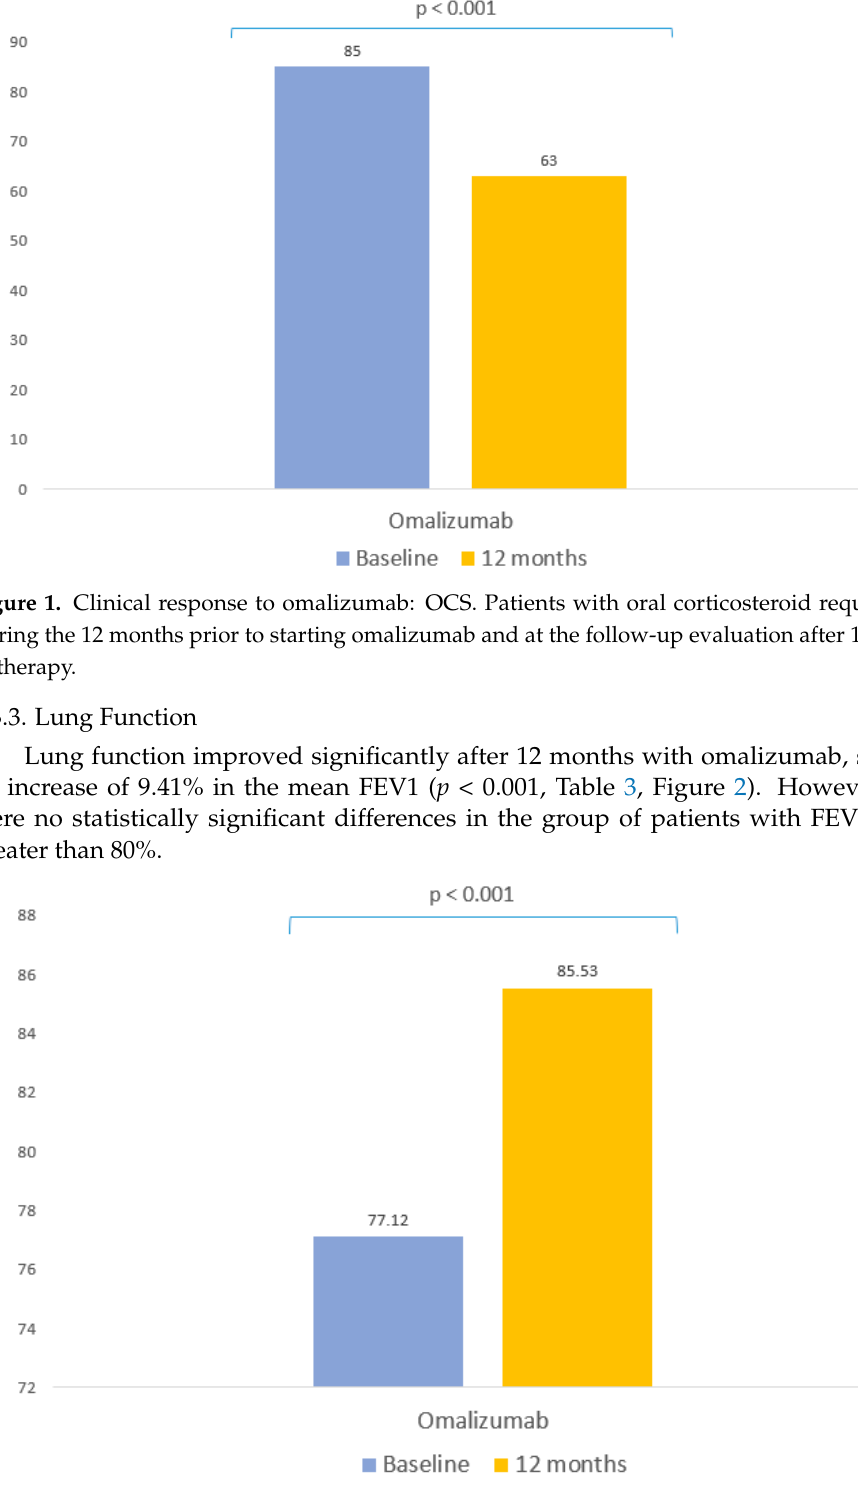
Figure 2. Clinical response to omalizumab: lung function. Mean percentage forced expiratory volume in the first second (%FEV1) before omalizumab and after 12 months of treatment.